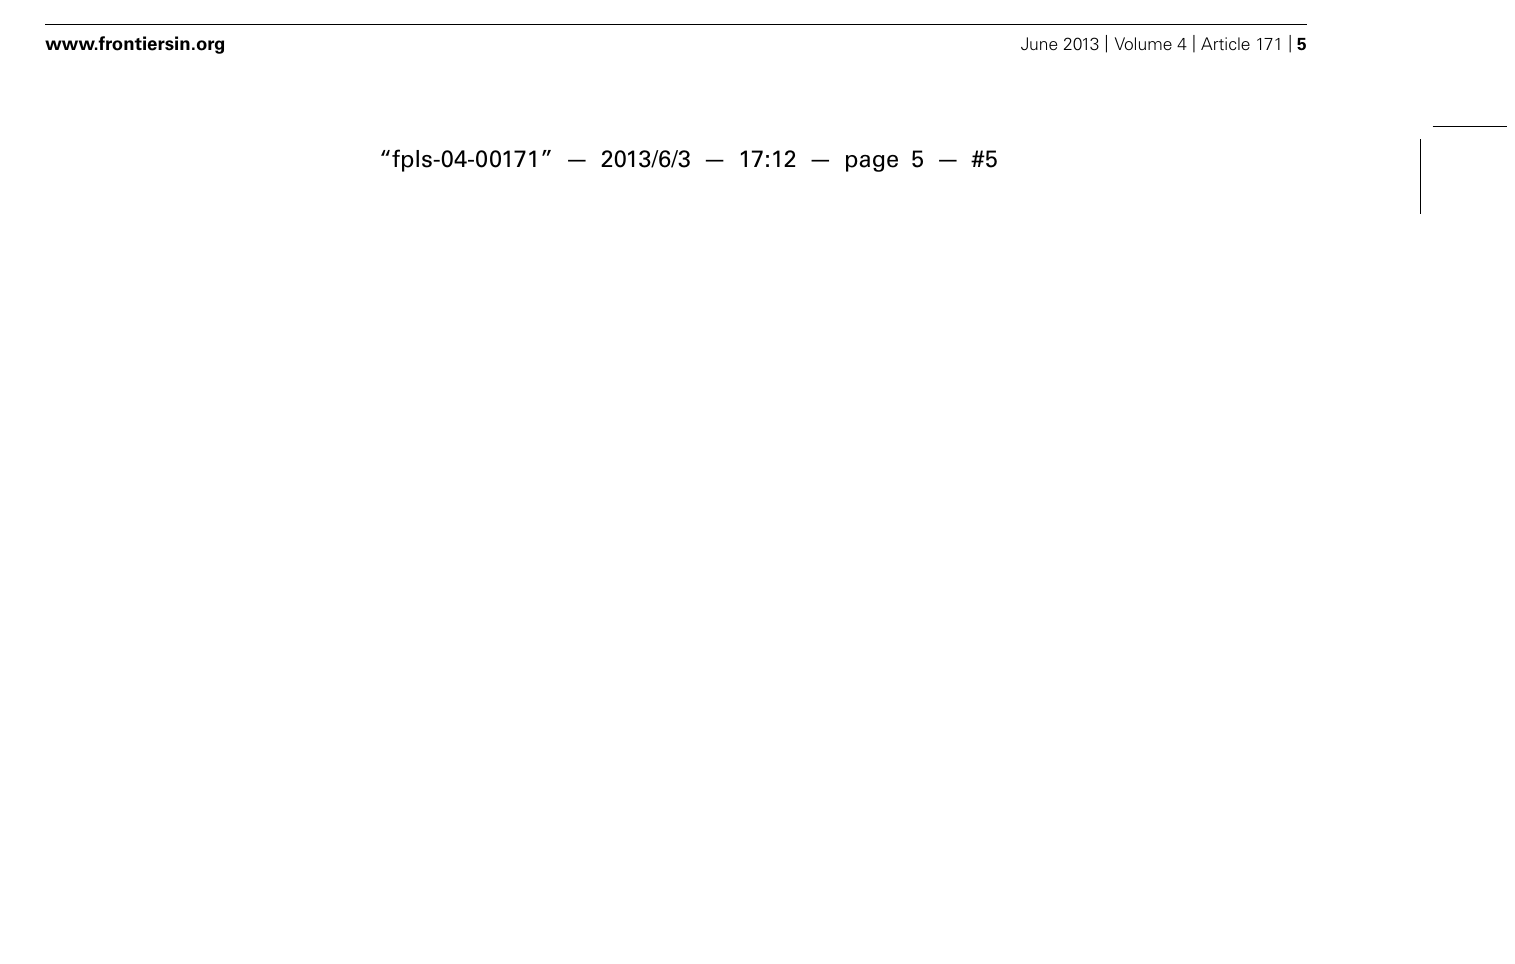
(sp: sieve plate). (D,E) A big accumulation of callose (c) at the sieve plates (sp), and occluding the sieve pores ( E , arrows), is visible in infected samples. Starch granules ( D , st) are detectable in the companion cell (cc; SE, sieve elements). (F) Groups of collapsed cells are present in the phloem of infected grapevine leaves (arrows); at the top, a sieve plate (sp) is still recognizable. In (A) and (E) bars correspond to 0.5 μ m; in (B) bar corresponds to 5 μ m. In (C) , (D) , and (F) bars correspond to 1 μ